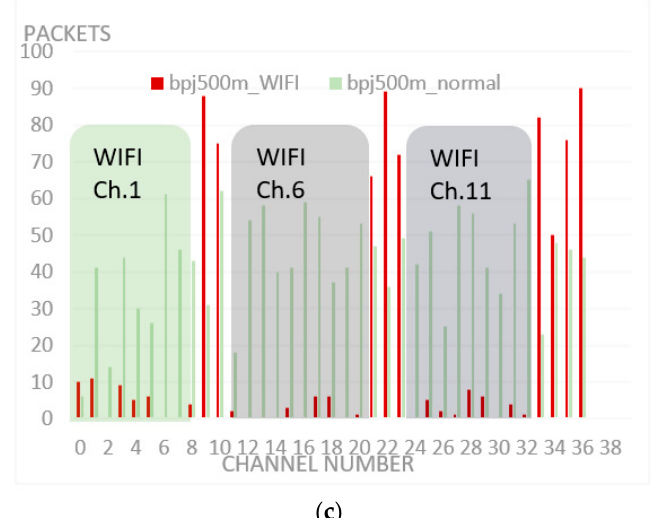
Figure 13. Received packets per BLE channel and their relationship with the main WiFi channels. ( a ) Received packets per channel at 100 m, ( b ) Received packets per channel at 300 m, ( c ) Received packets per channel at 500 m, comparing normal and coexistence environments.